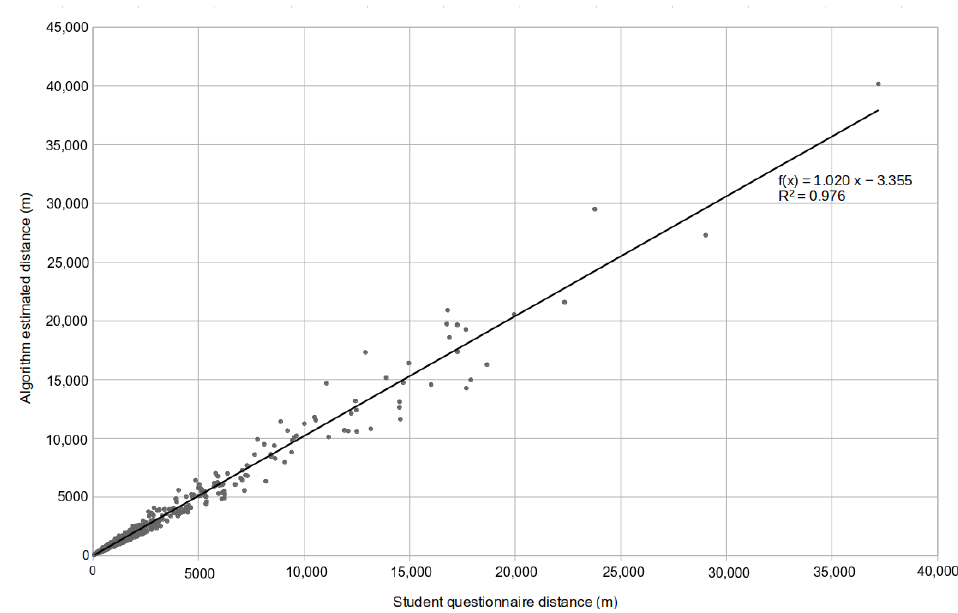
Figure 9. Linear regression analysis. Student questionnaire distance vs. algorithm estimated distance.